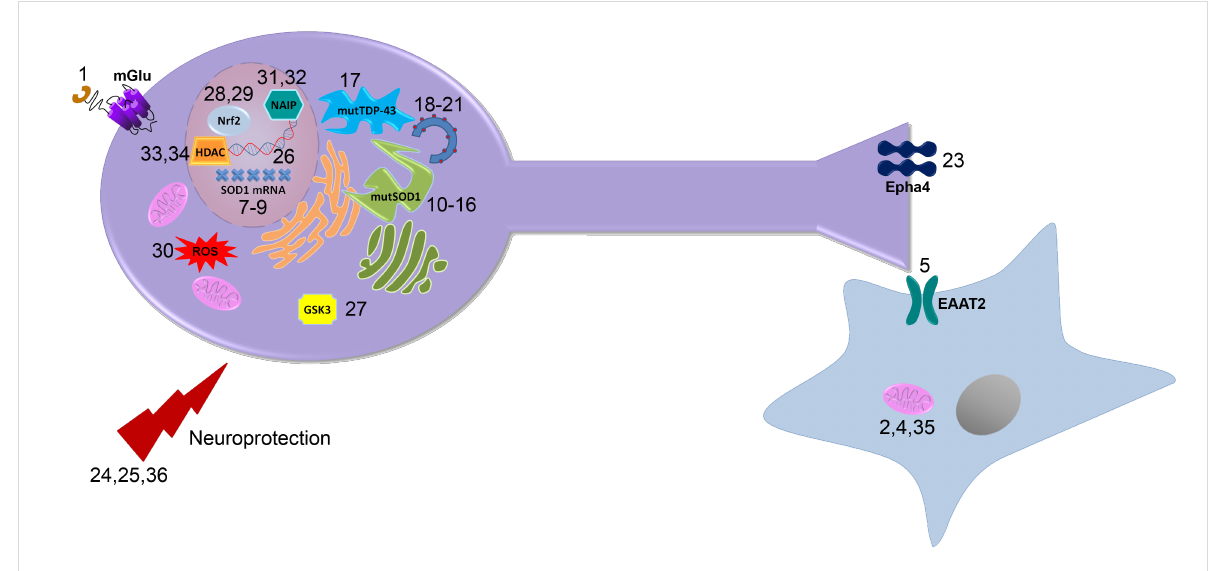
Figure 15: Targets of potential therapeutics: This diagram illustrates the physiological targets of each compound discussed in the review and how these compounds are believed to function in